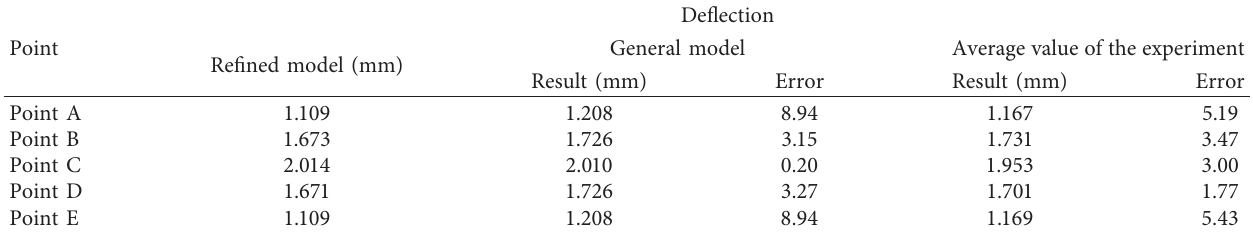
Table 3: Comparison of the deflections between the experiment and FE models.